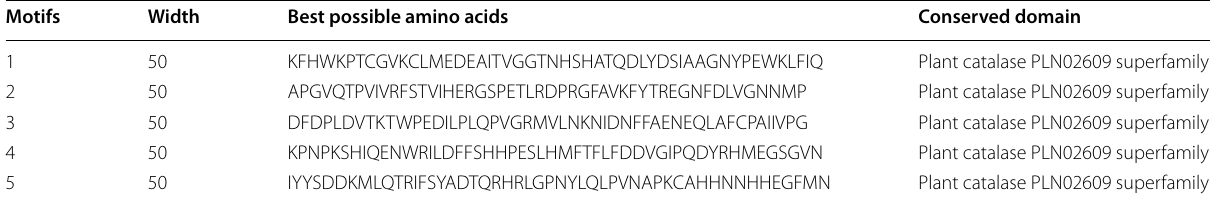
Table 3 The five motifs with best match possible amino acid sequences with their respective domain Motifs Width Best possible amino